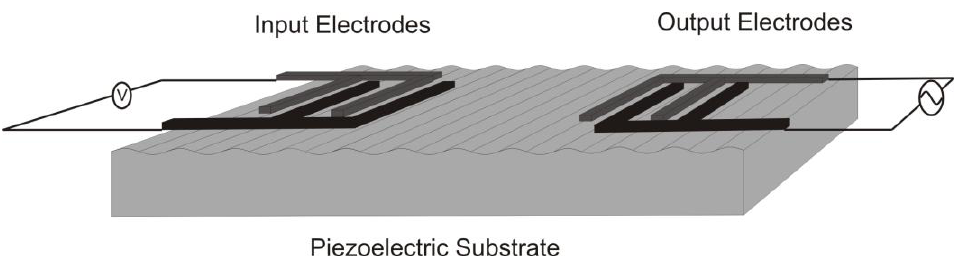
Figure 2. Layout of the SAW delay line